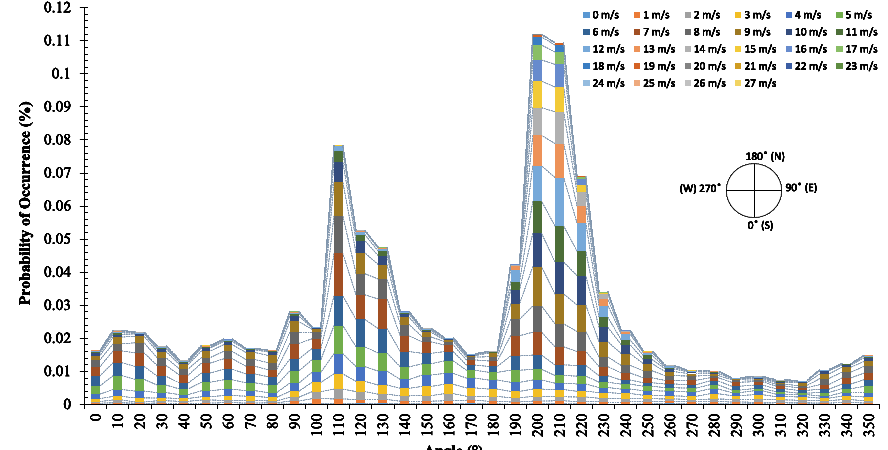
Figure 2. Histogram of wind speeds and directions for a year.